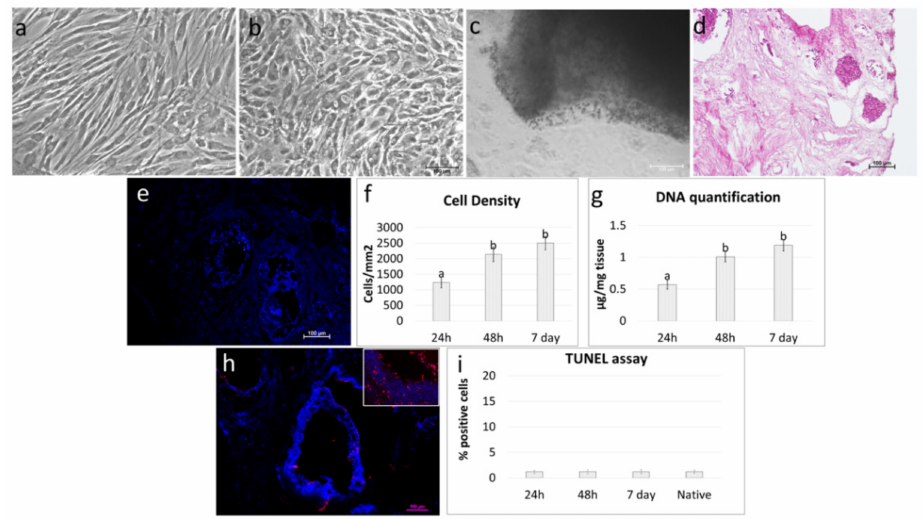
Figure 6. Repopulation of decellularized ovarian ECM-based scaffolds with pEpiE. ( a ) Representative image of porcine untreated fibroblasts showing the typical elongated shape. Scale bar = 100 µ m. ( b ) After 18 h of exposure to 5-aza-CR, the cells displayed a round epithelioid aspect and became smaller in size with larger nuclei and granular cytoplasm. Scale bar = 100 µ m. ( c ) pEpiE adhered and migrated to the decellularized ECM-based ovarian scaffolds. Representative image after 7 days of culture. Scale bar = 100 µ m. ( d ) H & E staining demonstrated the presence of pEpiE in the ECM-based scaffolds. Scale bar = 100 µ m. ( e ) DAPI staining confirmed the positivity for nuclei. Scale bar = 100 µ m. ( f ) Cell density analysis showed ECM-based scaffolds’ repopulation after 24 h, with a higher number of cells after 48 h and 7 days of coculture. Data are expressed as the mean ± the standard error of the mean (SEM). a and b indicate statistically significant differences ( p < 0.05). ( g ) DNA quantification demonstrated the presence of pEpiE in the ECM-based scaffolds after 24 h, with an increasing number of cells at 48 h, which was steadily maintained at Day 7. Data are expressed as the mean ± the standard error of the mean (SEM). a, and b indicate statistically significant differences ( p < 0.05). ( h ) Representative picture of the TUNEL assay showing positive cells in red. Nuclei were stained with DAPI (blue). Scale bars = 100 µ m and 50 µ m. ( i ) TUNEL-positive cell rates detected 24–48 h and 7 days after seeding were comparable to those identified in the native tissues (native). Data are expressed as the mean ± the standard error of the mean